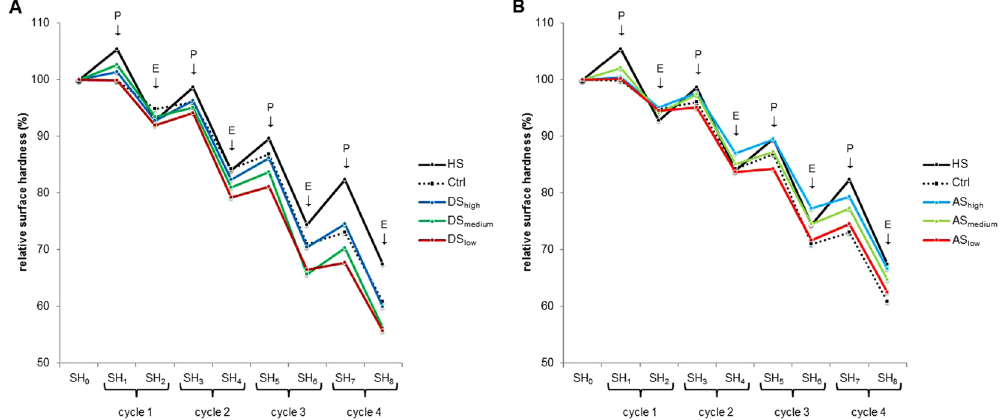
Figure 1. Change in mean relative SH during incubation-erosion cycles. ( A) SH of all DS groups compared to HS and Ctrl. (B) SH of all AS groups compared to HS and Ctrl. P marks measurements after saliva incubation periods; E marks measurements after erosions.